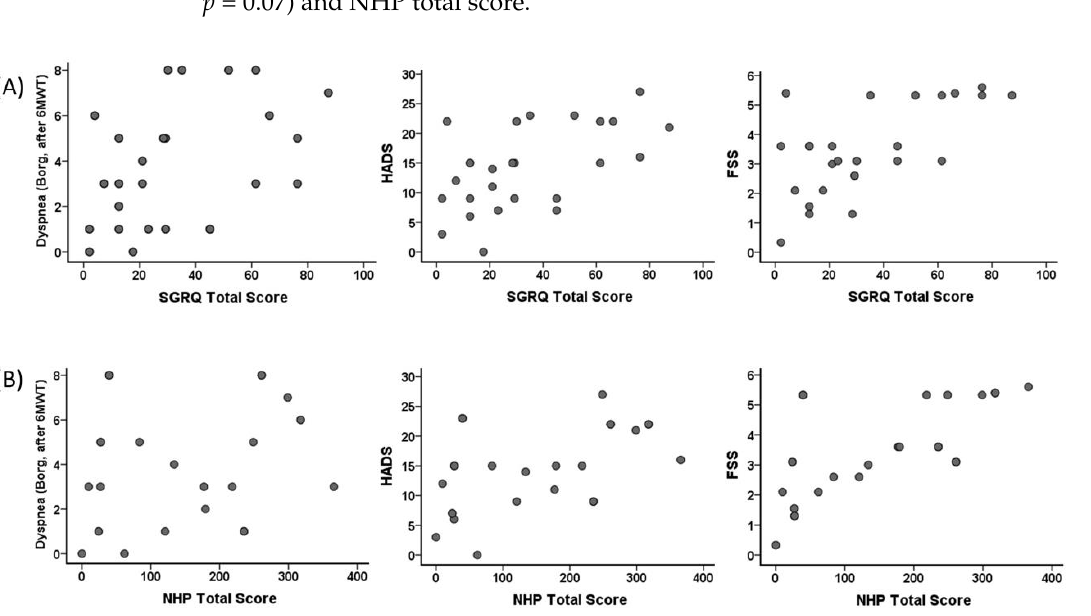
Figure 5. Correlation of the St. George Respiratory Questionnaire (SGRQ) total score with ( A ) dyspnea (Borg, after 6MWT) (r = 0.448, p = 0.02), Hospital Anxiety and Depression Scale (HADS) (r = 0.543, p = 0.004), and Fatigue Severity Scale (FSS) (r = 0.528, p = 0.006), and correlation of Nottingham Health Profile (NHP) total score with ( B ) dyspnea (Borg, after 6MWT) (r = 0.358, p = 0.07), HADS (r = 0.536, p = 0.005), and FSS (r = 0.723, p < 0.001) in the COVID-19 group.